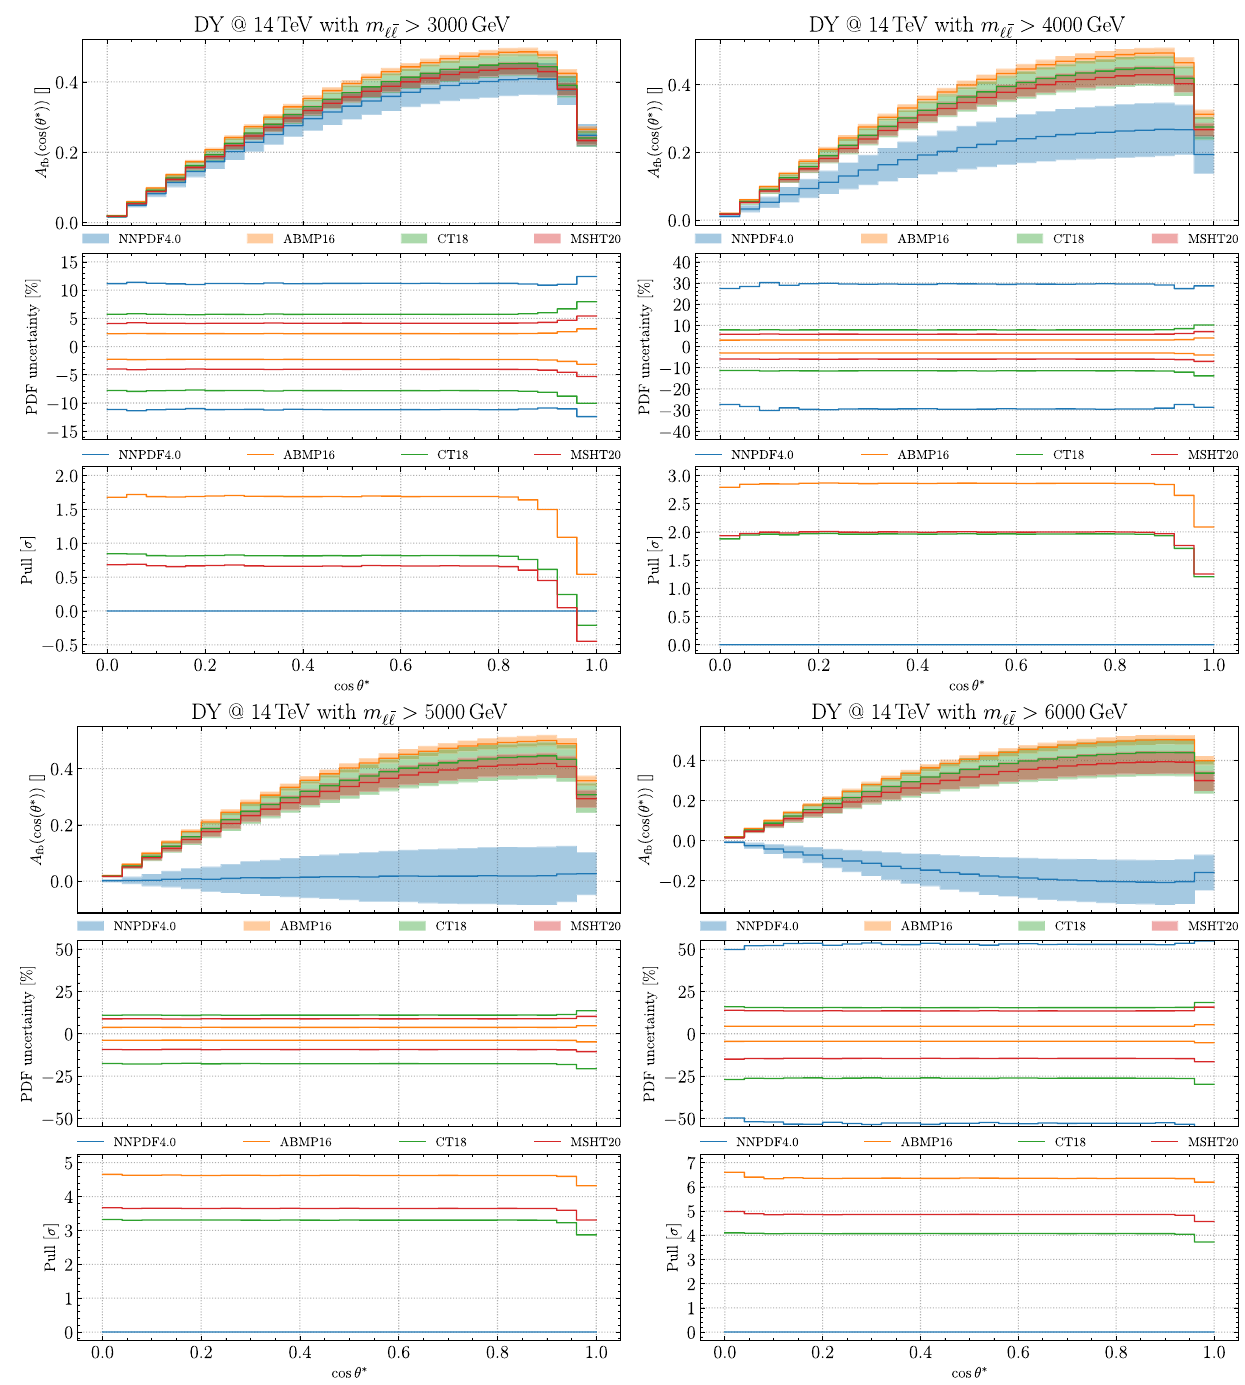
= 3 , 4 , 5 , and 6 (cid:2) ¯ (cid:2)